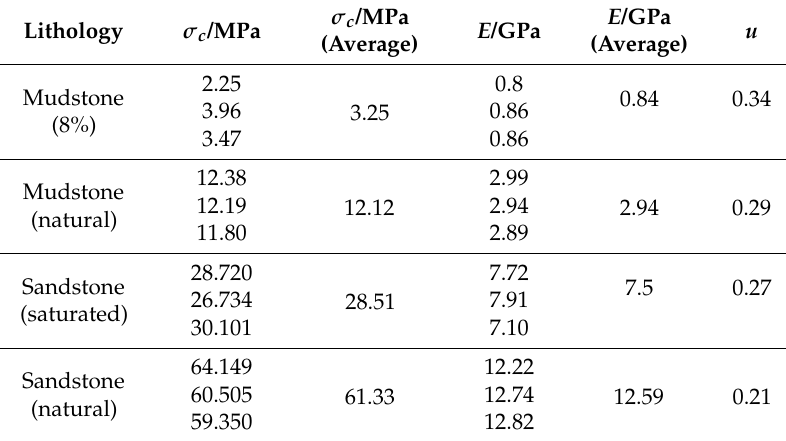
Table 2. The table of uniaxial compression experiment Table 2 The table of uniaxial compression experiment calculation.